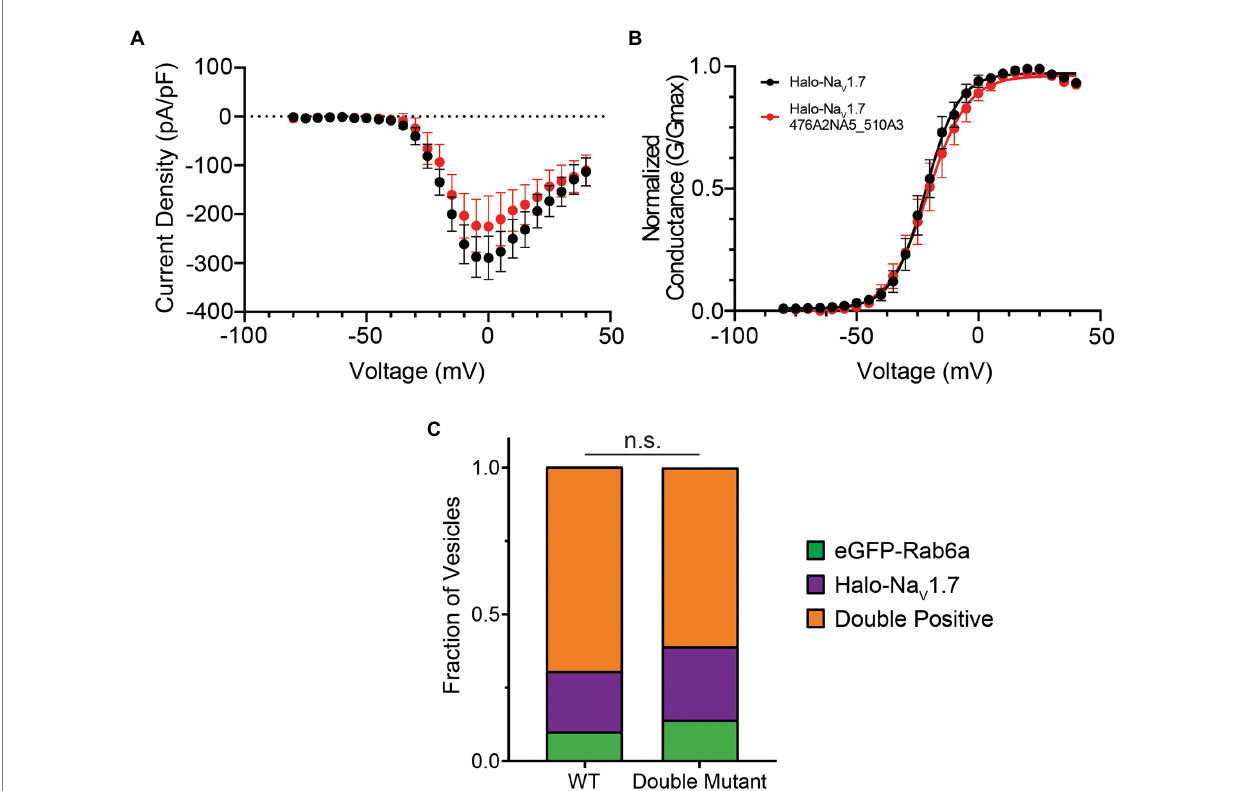
FIGURE 3 Mutating both polybasic motifs in the L1 of Na V 1.7 does not affect channel gating or co-trafficking with Rab6a. (A) The current–voltage relationship of Halo-Na V 1.7 476A2NA5_510A3 is similar to that of WT Halo-Na V 1.7 as assessed by automated voltage-clamp. Peak current density was not significantly different between the two channels ( − 225.4 ± 63.2 vs. − 289.3 ± 44.5 pA/pF for Halo-Na V 1.7 476A2NA5_510A3 ( n = 19) and WT Halo-Na V 1.7 ( n = 26), respectively; p = 0.40 by unpaired t -test). (B) The voltage-dependence of activation is not significantly different between the two channels. Conductance-voltage relationships were fit by Equation 3 (Supplementary material). Half-maximal activation voltages were similar between the two constructs ( − 21.7 ± 0.5 mV vs. − 20.8 ± 0.7 mV, for WT Halo-Na V 1.7 ( n = 26) and Halo-Na V 1.7 476A2NA5_510A3 ( n = 19) respectively; p = 0.29 by unpaired t -test). (C) The fraction of vesicles that demonstrate co-transport of Na V 1.7 and Rab6a is not affected by mutation of both polybasic motifs.